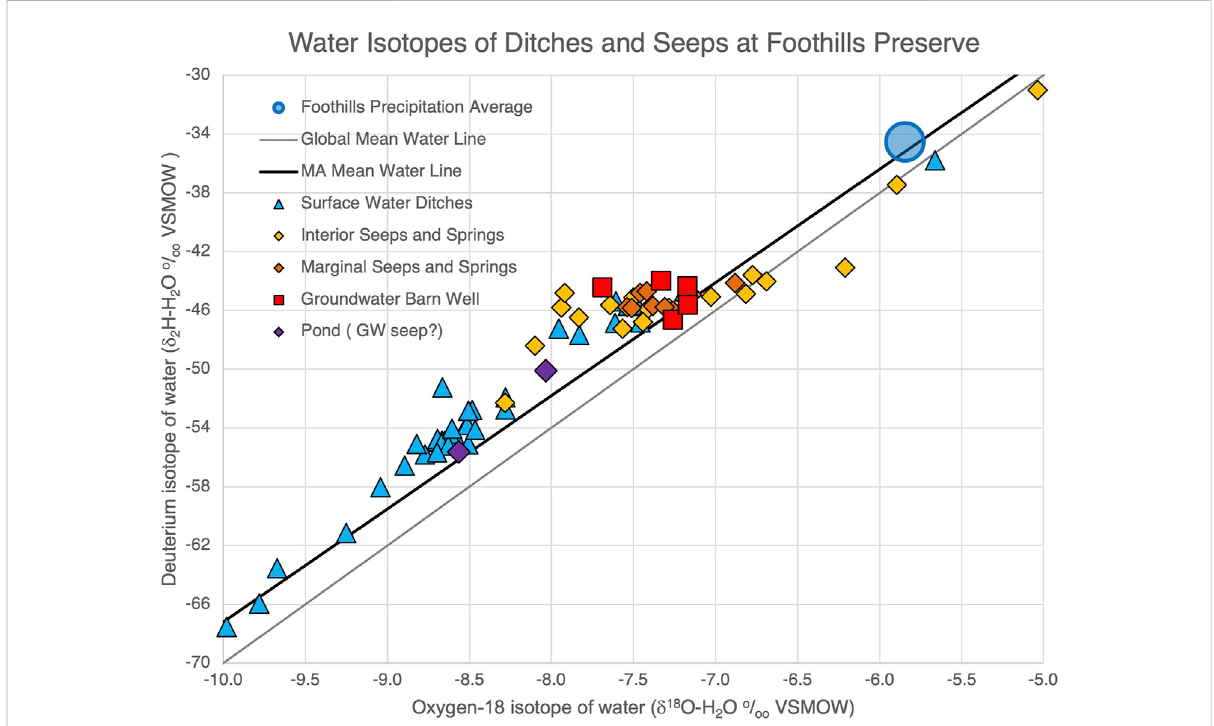
FIGURE 9 Isotopic composition of Foothills Preserve surface waters. Trendlines shown include the Global Mean Water Line (GMWL, thin grey), and MassachusettsMWL(MAMWL,thickblack).Symbologyofsamplesourcesinclude:AverageFoothillsPreserveprecipitation(largebluecircle),surface water ditches (cyan triangle symbols), seeps and springs from the bog interior (yellow diamonds) and bog margins (orange diamonds), the Barn groundwater well (red squares), and pond (purple